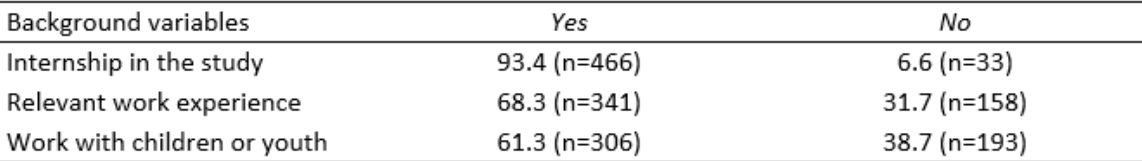
Table 3. 5 The percentage of students in the study with experience from, respectively: a) at least a two-week internship period during their studies; b) work experience relevant to the educational programme, current or present, and c) work experience related to children and